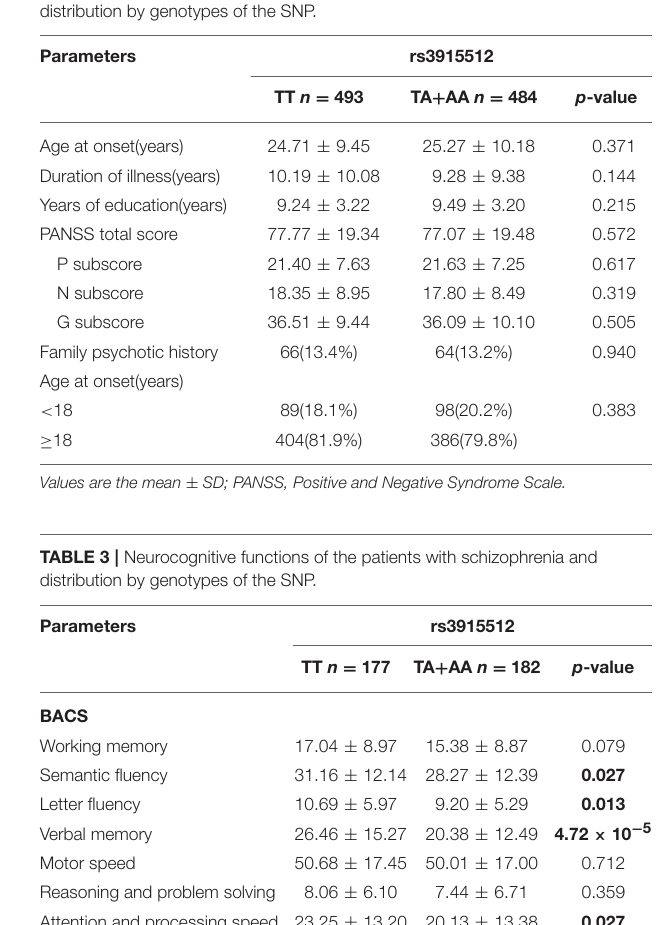
TABLE 2 | Clinical characteristics of the patients with schizophrenia and distribution by genotypes of the SNP. Parameters